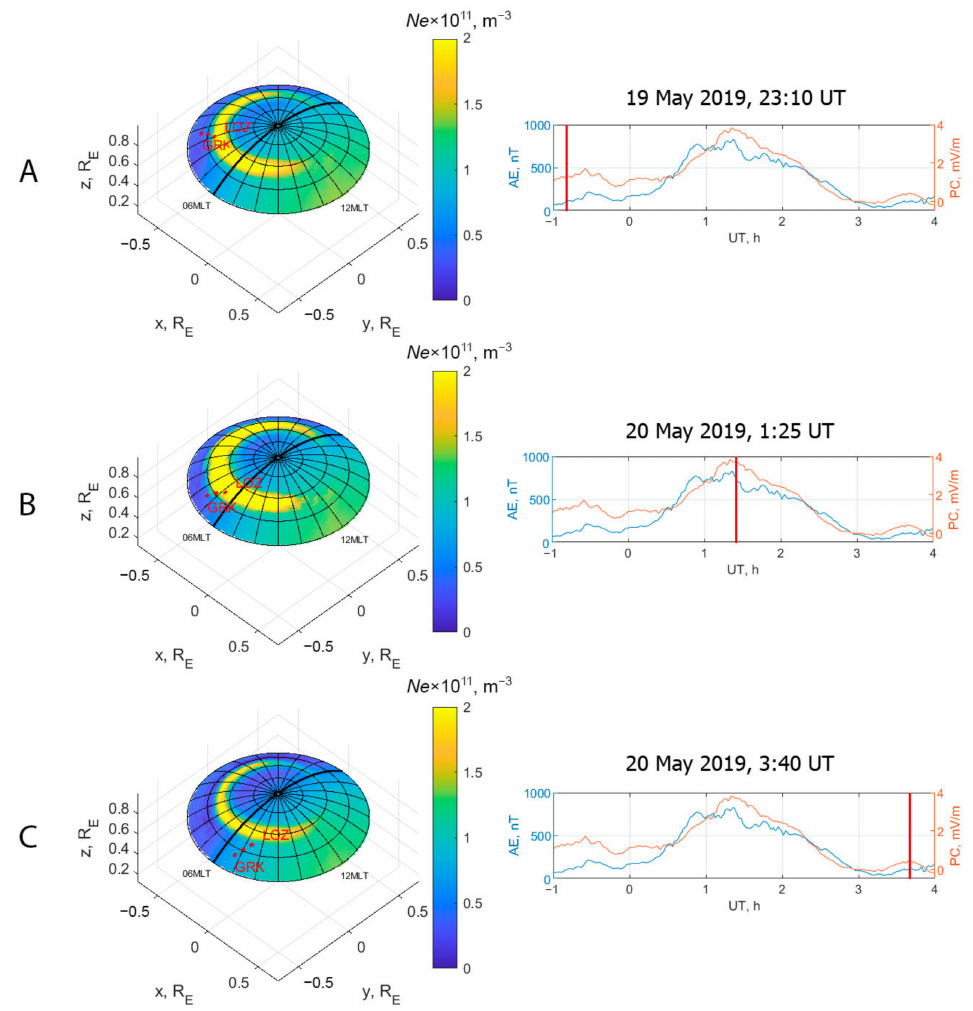
Figure 5. The maps of the AIM-E (PC) electron concentration at the E layer maximum for three time moments: ( A ) 23:10 UT (before the substorm); ( B ) 1:25 UT (substorm expansion); ( C ) 3:40 UT (after the substorm). Red dots in the maps mark observation points: Gorkovskaya station (GRK), Lovozero station (LOZ), and the central point of the radio path Gorkovskaya–Lovozero. Panels on the right show the variation of the AE and PC indices from 23:00 UT on 19 May 2019 to 4:00 UT on 20 May 2019. Red vertical lines are the timestamps for the maps shown on the